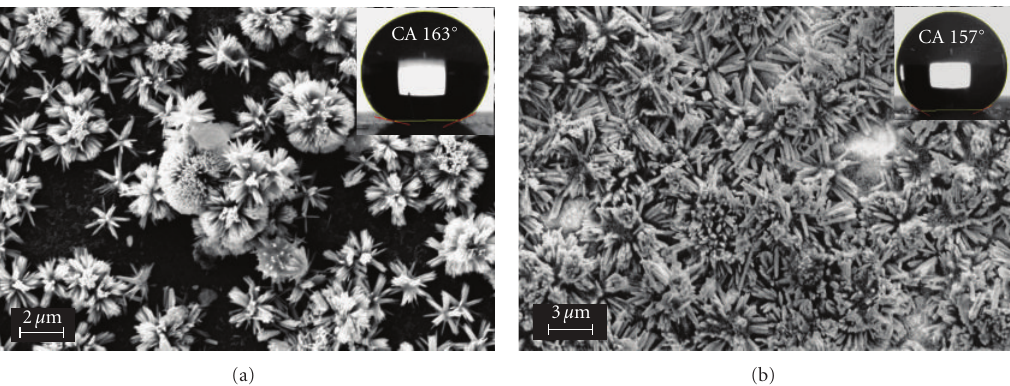
Figure 4: Surface morphology of ZnO-PTFE coating treated with stearic acid (a) and fluoroalkyl silane (b). Insets show the image of the water drop on the film